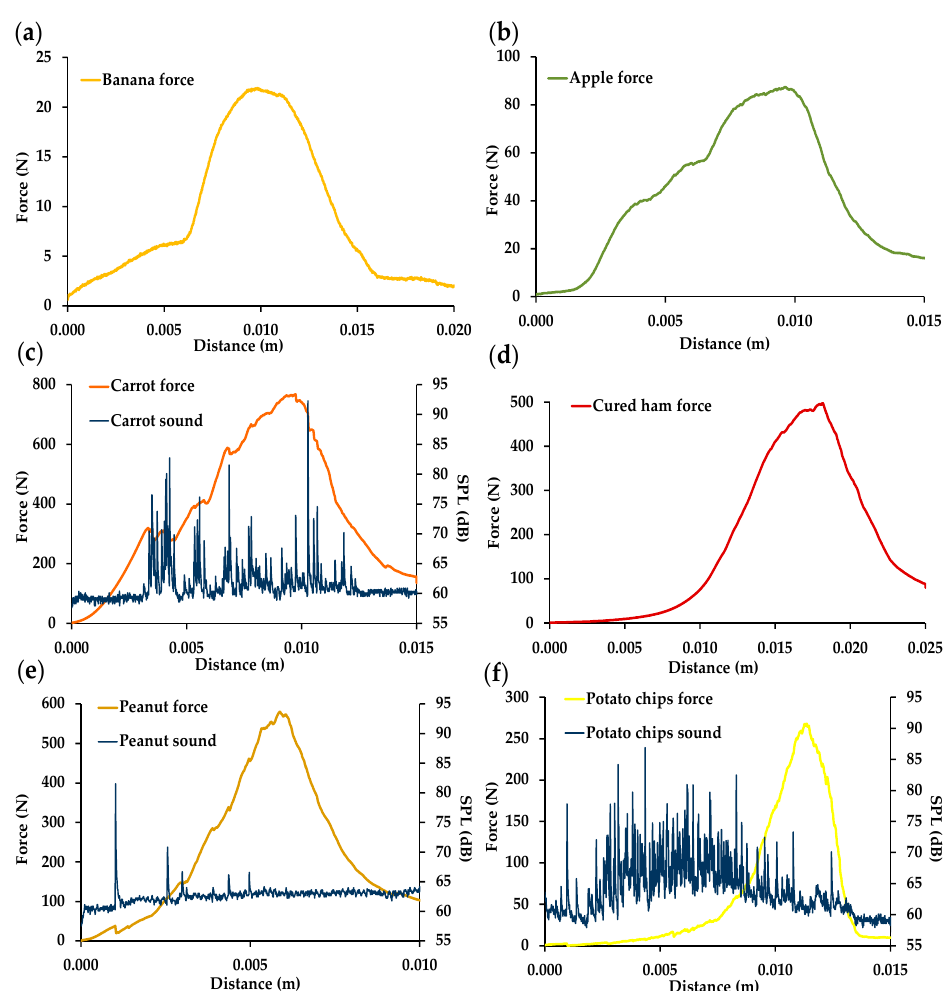
Figure 1. Typical miniature Kramer force–distance curves of selected foods: ( a ) banana; ( b ) apple; ( c ) carrot with sound pressure level (SPL)–distance curve; ( d ) cured ham; ( e ) peanut with SPL–distance curve; ( f ) potato chips with SPL–distance curve. Table 1. Mechanical and acoustic properties of foods obtained by using the miniature Kramer shear cell and food moisture contents.